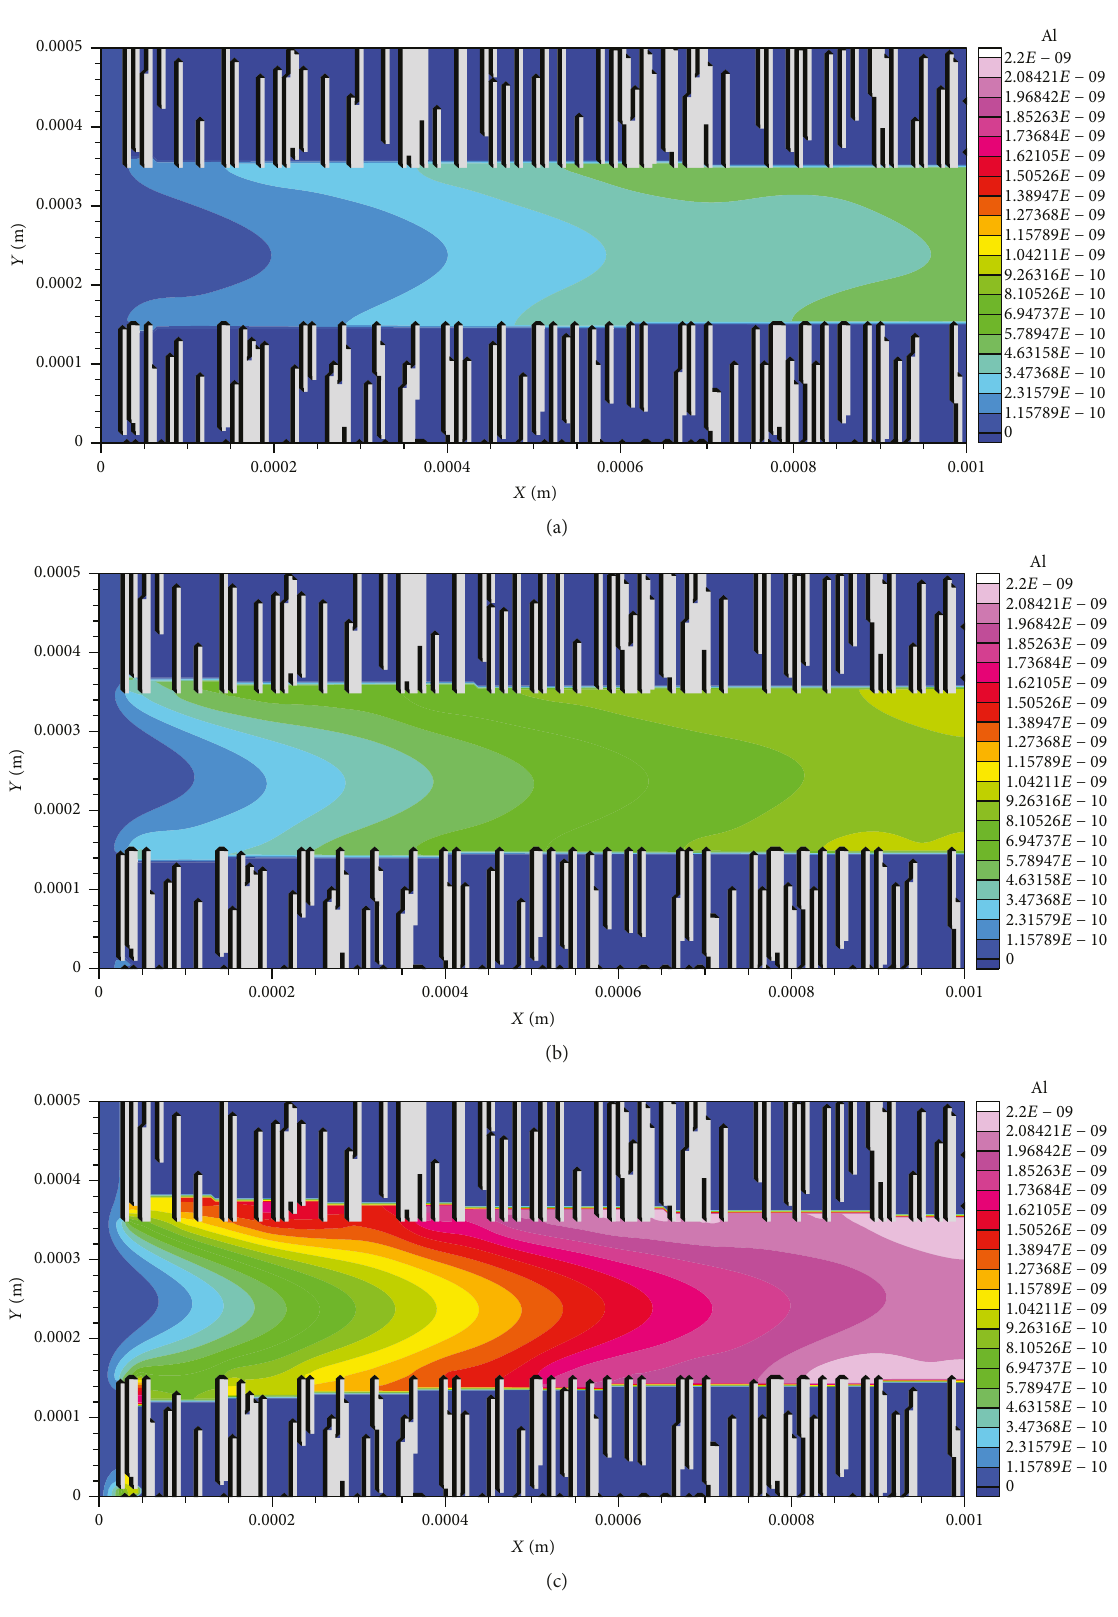
Figure 23: Al concentrations (mol/L) at (a) t = 1 3 hr, (b) t = 2 8 hr, and (c) t = 6 4 hr. In all three cases, Pe =2.6 and kaolinite is illustrated in light